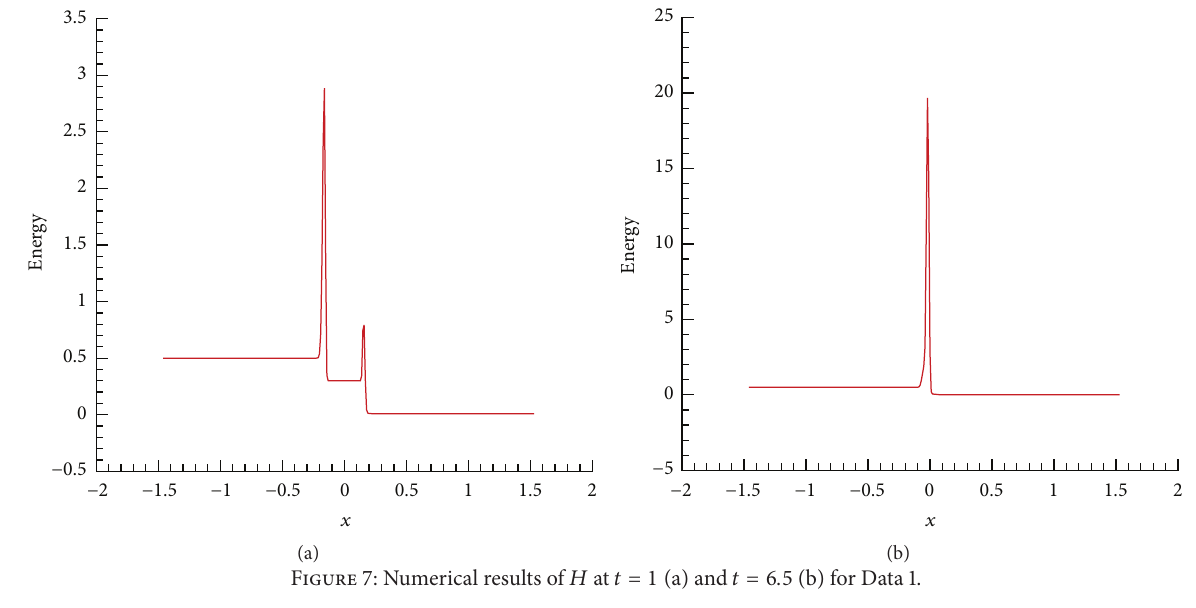
Figure 7: Numerical results of 𝐻 at 𝑡 = 1 (a) and 𝑡 = 6.5 (b) for Data 1.